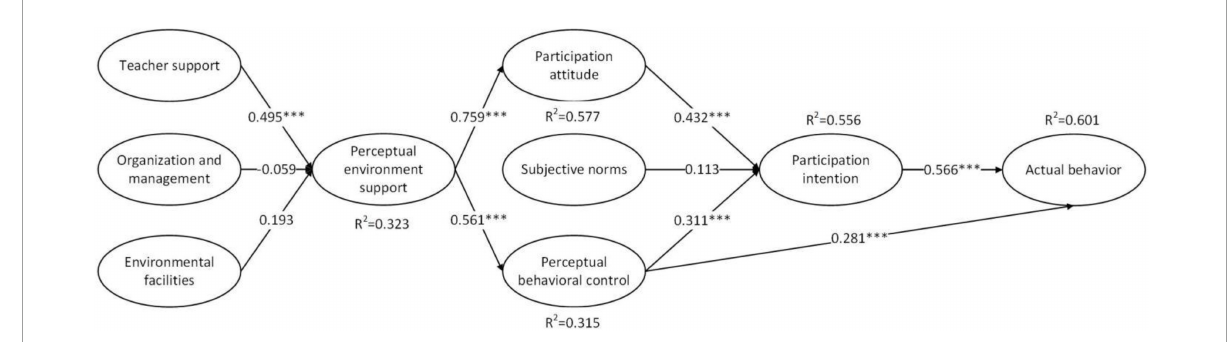
FIGURE2 Structural model. ***At the 0.01 level (double tail), the correlation is